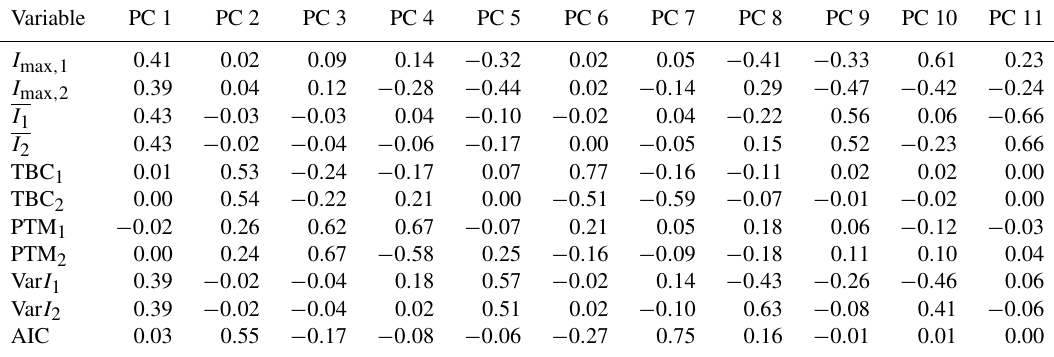
Table C1. PC coefficients, also known as loadings or eigenvectors, derived from performing a PCA on the standardized (mean centered and normalized to standard deviation) PbP data matrix of original particle variables. PCA was performed on 10000 particles composed of an equal number of aspherical and spherical particles, randomly selected from the entire calibration data set. Each column contains the coefficients for one PC, which are given by a linear combination of the original variables (rows).